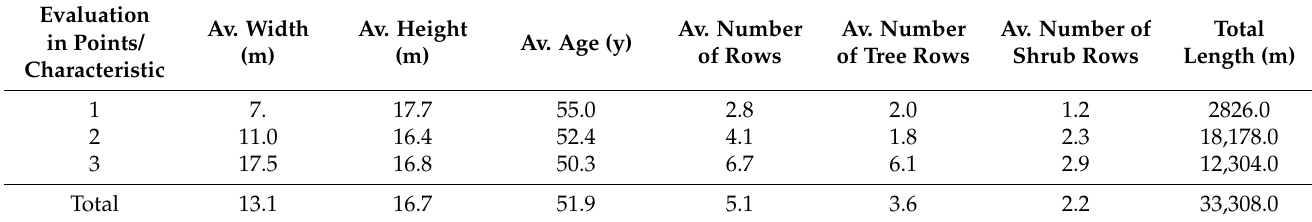
Table 4. Evaluation of windbreaks parameters.